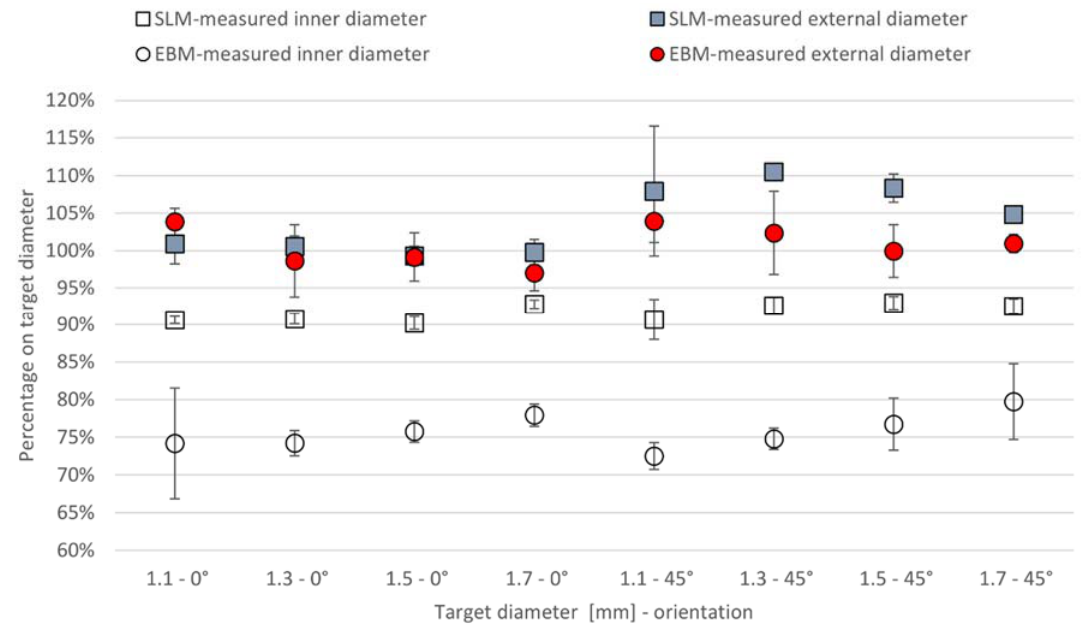
Figure 10. Measured external diameters and measured inner diameters for single struts. Results are shown as mean values with the corresponding standard deviations ( n = 10 for each design).